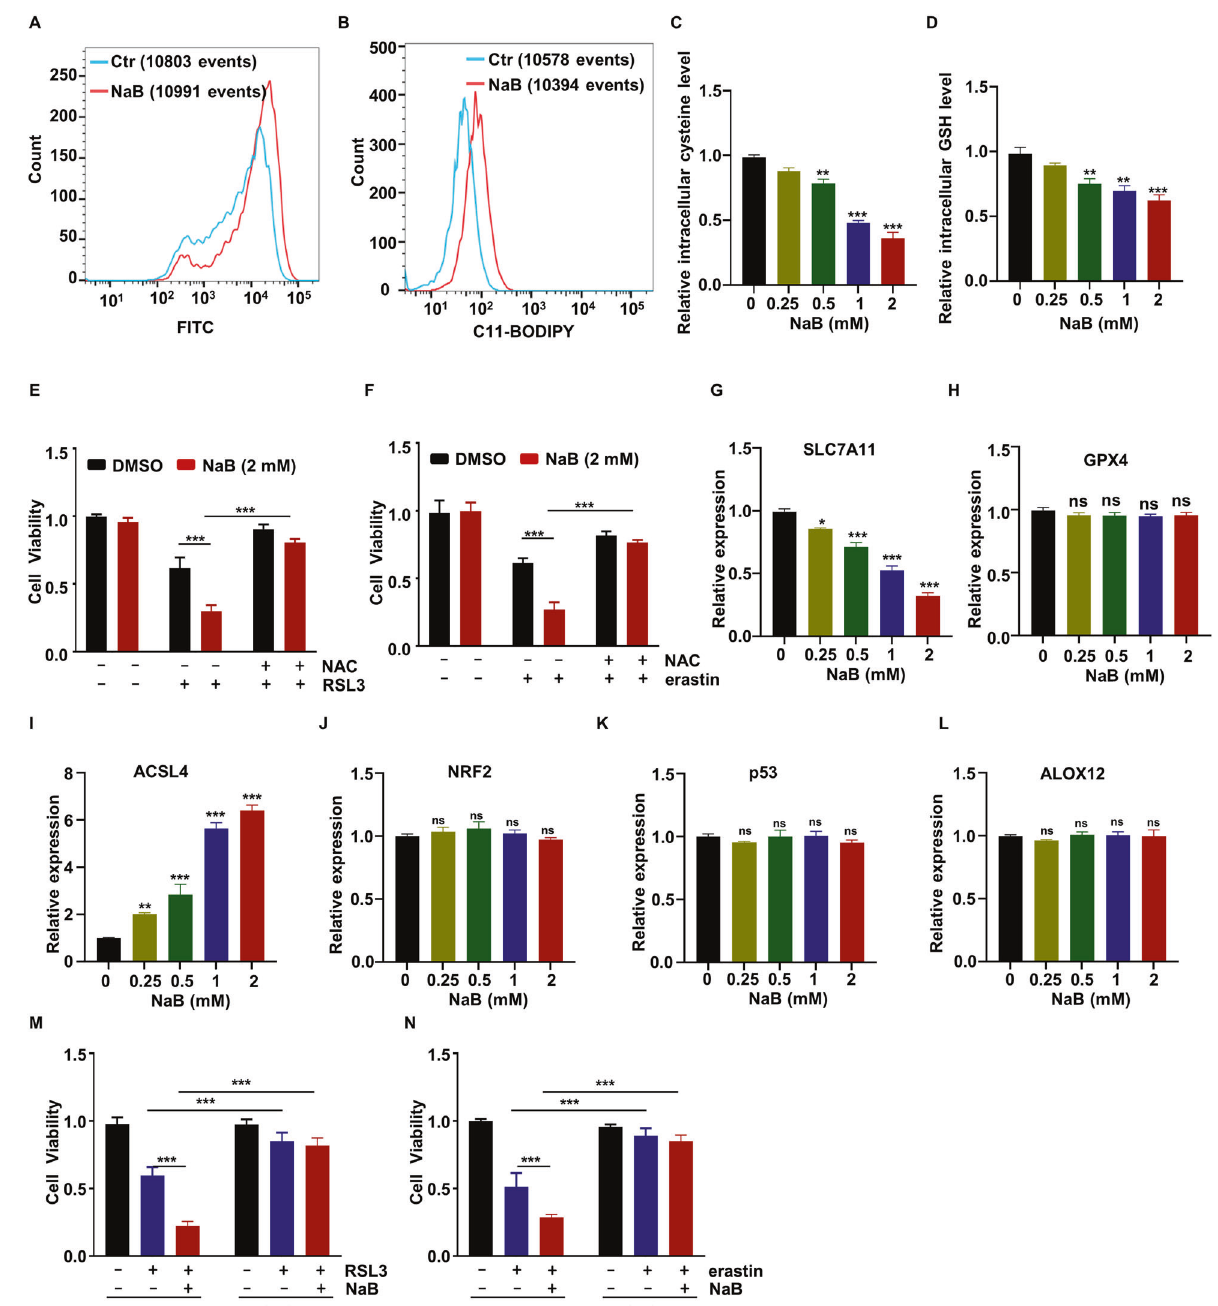
Fig. 2 Promotion of ferroptosis by butyrate via increase in lipid ROS production and decrease in the expression of SLC7A11. HT29 cells were treated with NaB (2 mM) for 24 h, ROS production ( A ) and lipid ROS levels ( B ) were determined using fl ow cytometer. HT29 cells were treated with different concentrations of NaB for 6 h, and relative intracellular cysteine ( C ) and GSH ( D ) levels were showed. HT29 cells were treated with RSL3 (1 μ M) ( E ) or erastin (10 μ M) ( F ) in combination with NaB and NAC (2 mM) for 6 h or 20 h, and the cell viability was examined using CCK-8. HT29 cells were treated with NaB for 6 h, and the expression of SLC7A11 ( G ), GPX4 ( H ), ACSL4 ( I ), NRF2 ( J ), p53 ( K ), and ALOX12 ( L ), were measured using qRT-PCR. Vector and Flag-SLC7A11-overexpressing cells were treated with RSL3 ( M ) or erastin ( N ) in combination with NaB (2 mM) for 6 h or 20 h, followed by cell viability